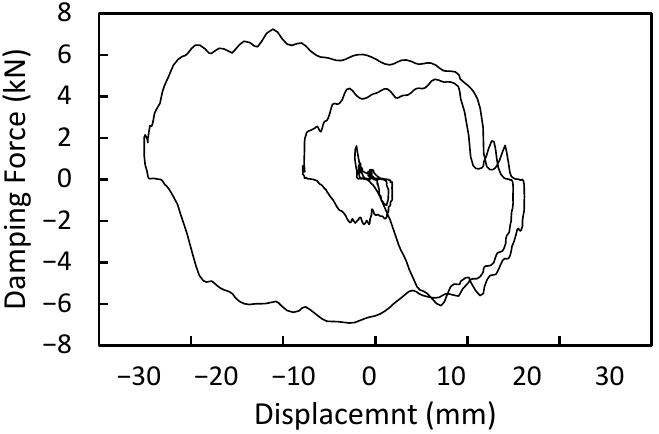
Figure 21. Identified damping coefficient from shake table test of bridge model. 5. Conclusions In this study, SSAWT-oMAMD is proposed by using SSAWT as the preprocessing algorithm for system identification with optimized MAMD. The adaptation algorithm of SSAWT is effective in separation of the signal components, and the synchro-squeezing technique lowers energy dispersion and sharpens the ridgelines of the time–frequency representation. SSAWT results with different mother wavelets are compared, and the Morlet wavelet is selected as a suitable candidate for clear time–frequency representation.